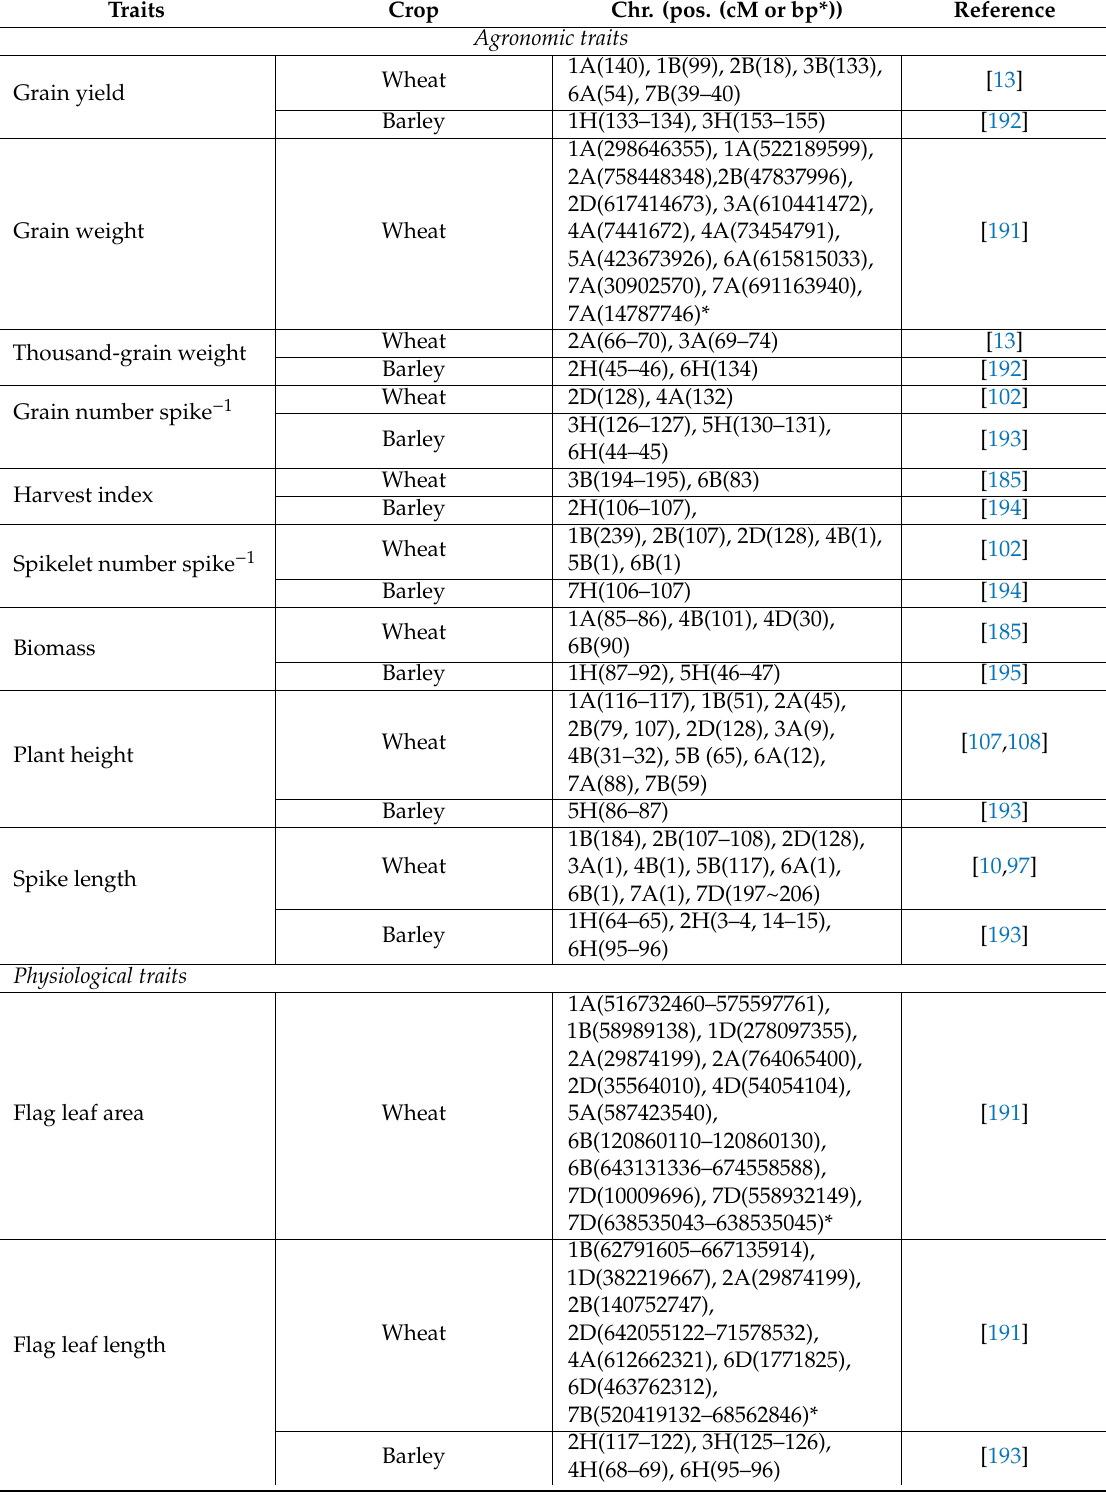
Table 3. The most significant genomic regions with genetic / physical position associated with agronomic, physiological and metabolite traits in wheat and barley using the genome-wide association study (GWAS)